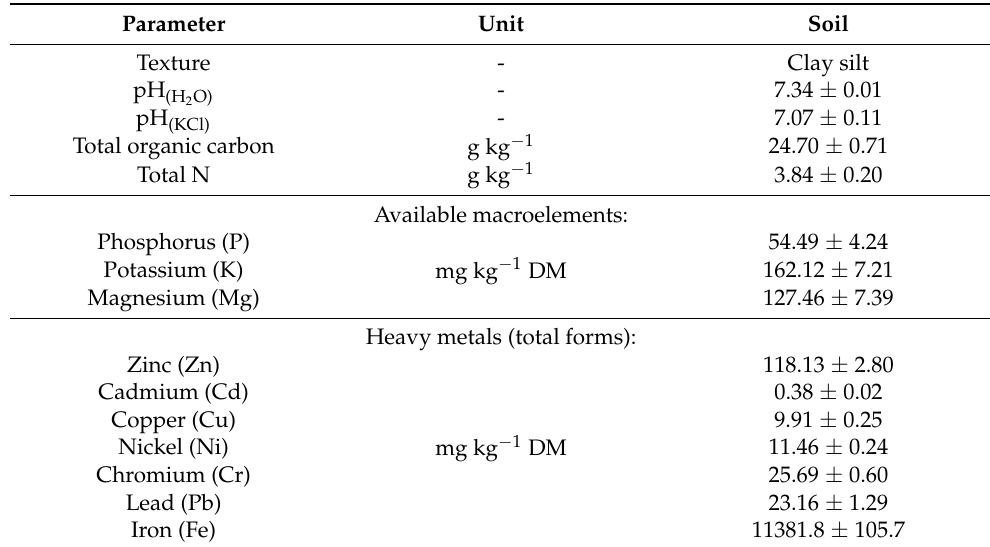
Table 1. Physico-chemical composition of soil used in the